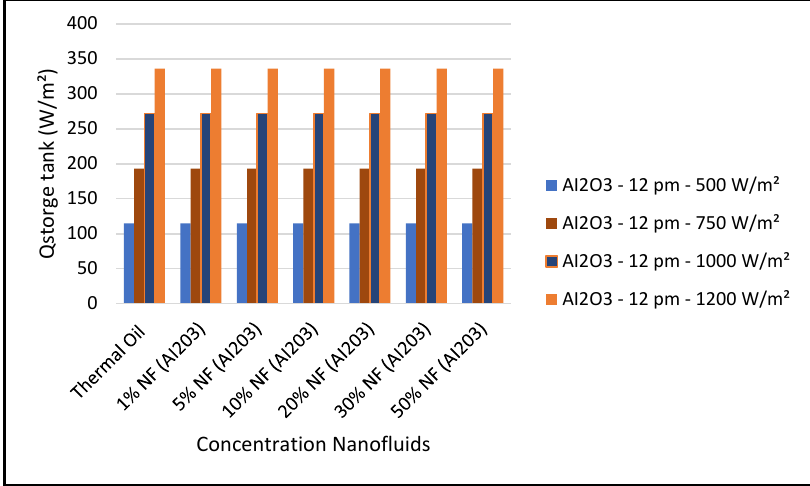
Figure 20. CSP collector power collected at different concentrations of Al 2 O 3 and solar radiations.